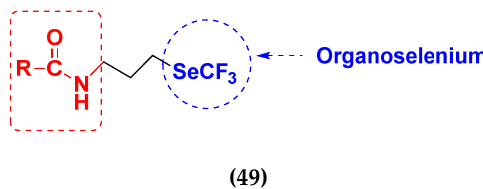
Figure 56. Organoselenium hybrid derivatives ( 49 ). Table 43. In vitro cytotoxic activities of organoselenium hybrid compounds 49 ( a – c ). Compound Compound No.